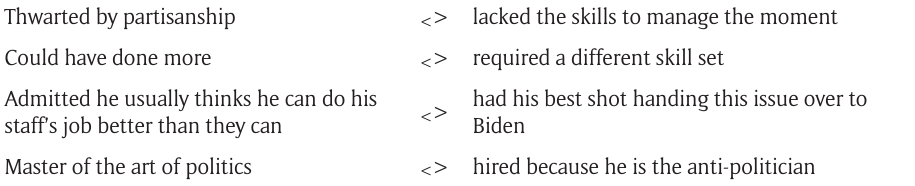
Table 1: These are direct excerpts from two web articles. Contrastive relations immanent to sequential, or nearby sentences in the articles themselves are being pulled out of context, for the purposes of highlighting how they manifest a differential; some kind of (admit- tedly abstract) analogical ratio of ‘more/less’. For the purposes of a more ontogenetically- inflected style of information processing, these differentials might be operationalized—by the author or others, over time—through some kind of technical ‘hinting’ strategy that marks the ratios in a collective practice—a kind of ontogenetic “hyper sense ” that builds on the strategies of lexia-based hyper text